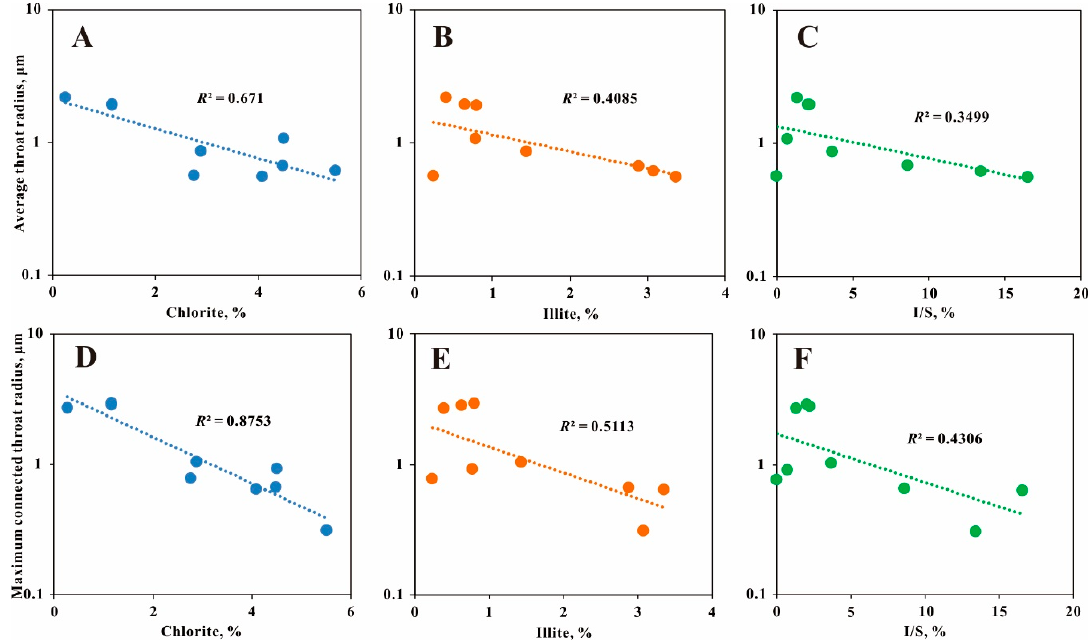
Figure 17. Negative relationships between average throat radius derived from RMIP experiments and contents of chlorite, illite, I/S ( A – C ), and negative associations between maximum connected throat radius derived from RMIP experiments and contents of chlorite, illite, I/S ( D – F ).